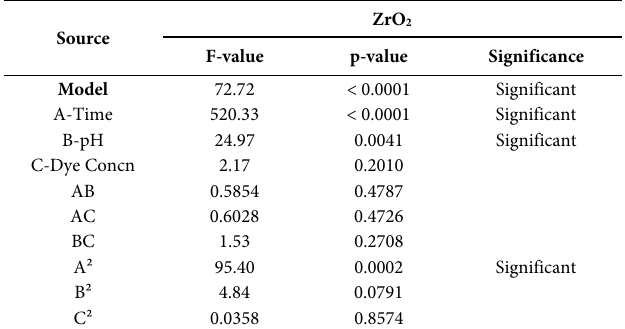
Table 5: shows the results of the ANOVA for the obtained quadratic equation Table 5. shows the results of the ANOVA for the obtained quadratic ZrO 2 Source F-value p-value Significance Model 72.72 520.33